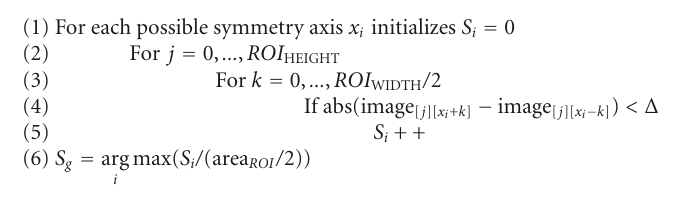
Algorithm 2: Gray level symmetry computation procedure.